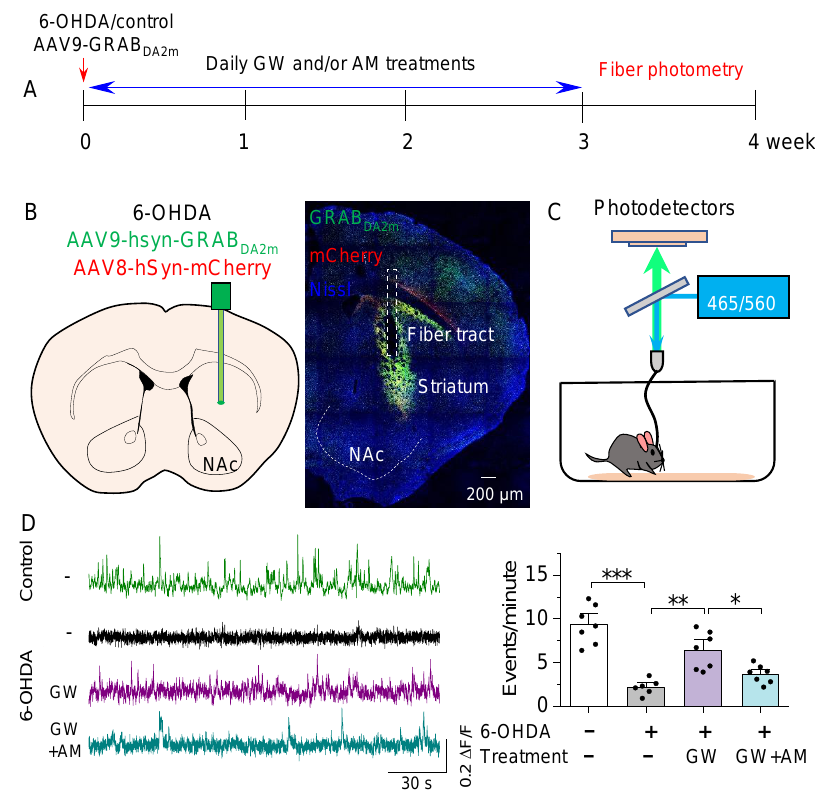
Figure 4. GW ameliorated the in vivo reduction in spontaneous dopamine transients in the NAc. ( A ) Timeline of intra-striatal injection of 6-OHDA, AAV9-GRABDA2m and AAV8-mCherry, drug treatments, and fiber photometry recording. ( B ) Diagram showing targeting of AAV and cannula implant to the NAc (left) and a representative post hoc validation of AAV expression and optic fiber position (right). ( C ) Schematic demonstrating the path of excitation LEDs and reporter emission signals during fiber photometry recording. ( D ) Left, representative traces of GRAB DA2m ΔF/F in the NAc of mice in control and treatment groups. Intra-striatal 6-OHDA injections significantly decreased the number of events/min relative to control injections (*** p < 0.001; n = 6 – 7 mice). Right, chronic treatment with GW treatment mitigated the decrease in dopamine event frequency by 6-OHDA (** p = 0.001; n = 6 – 7 mice). The effect of GW was blocked by co-treatment with AM (* p = 0.032; n = 7 – 7 mice).